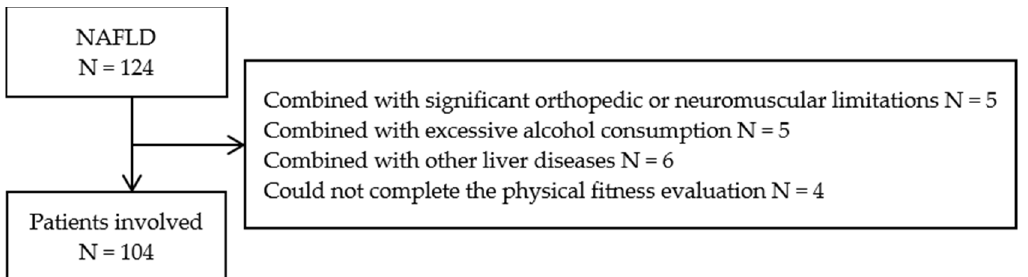
Figure 1. Flow chart of patients’ selection.